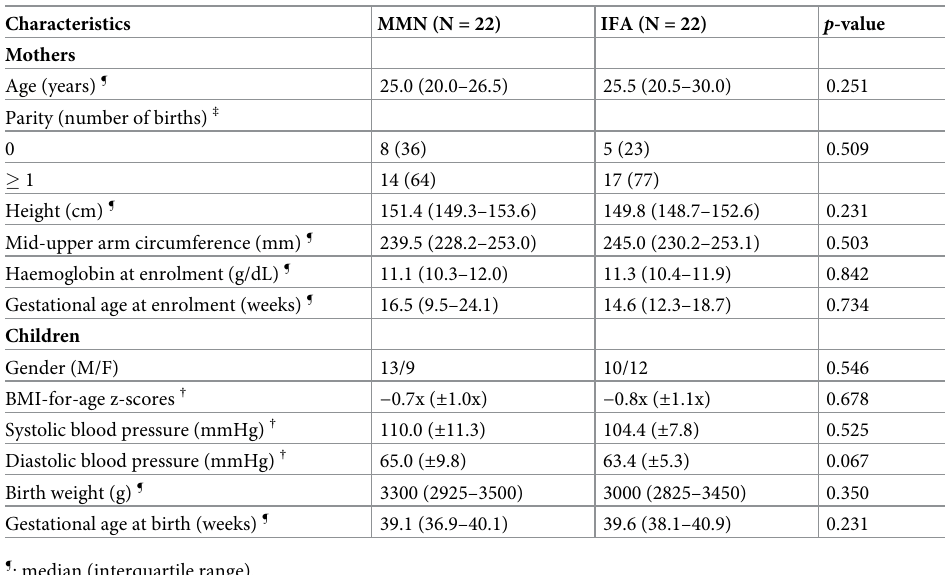
Table 1. Baseline characteristics of mother-child dyads.